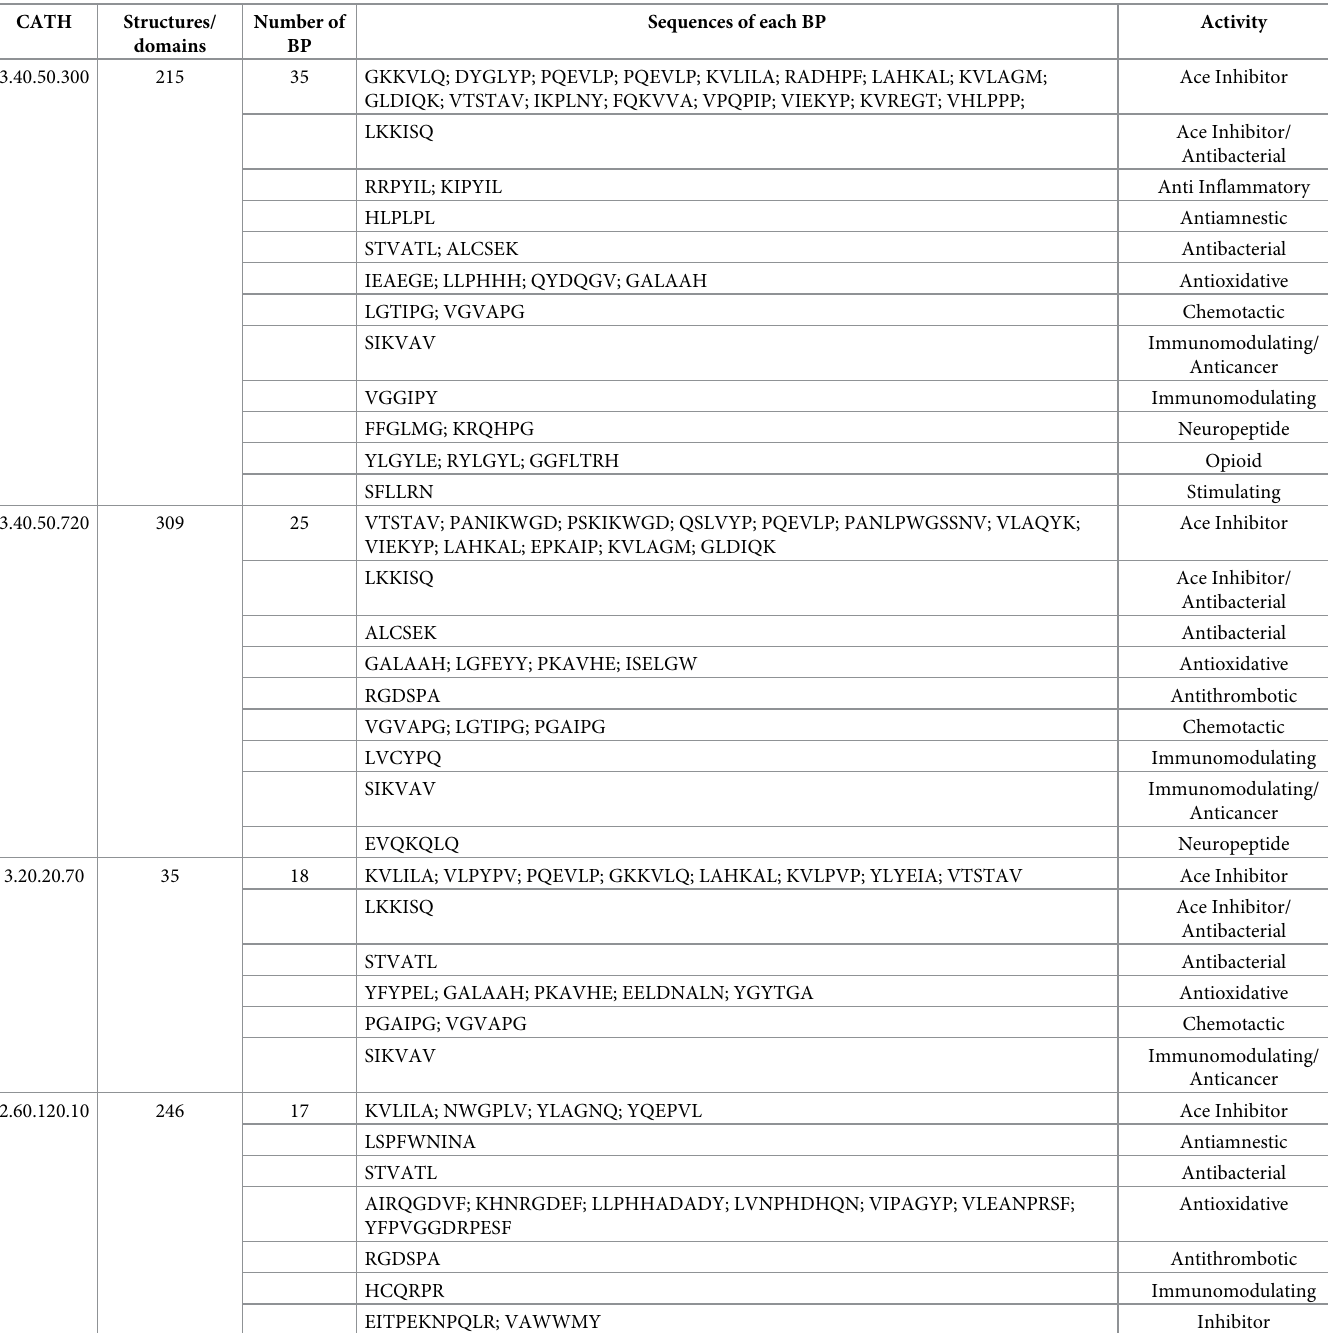
Table 2. Detail of the sequence and activity of biopeptides of the first four superfamilies with the highest number of biopeptides. The activity corresponds to the clas- sification in BIOPEP. CATH Structures/